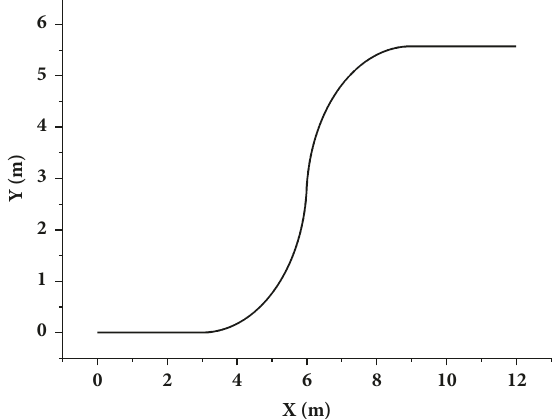
Figure 9: Reference trajectory of the crawlers.